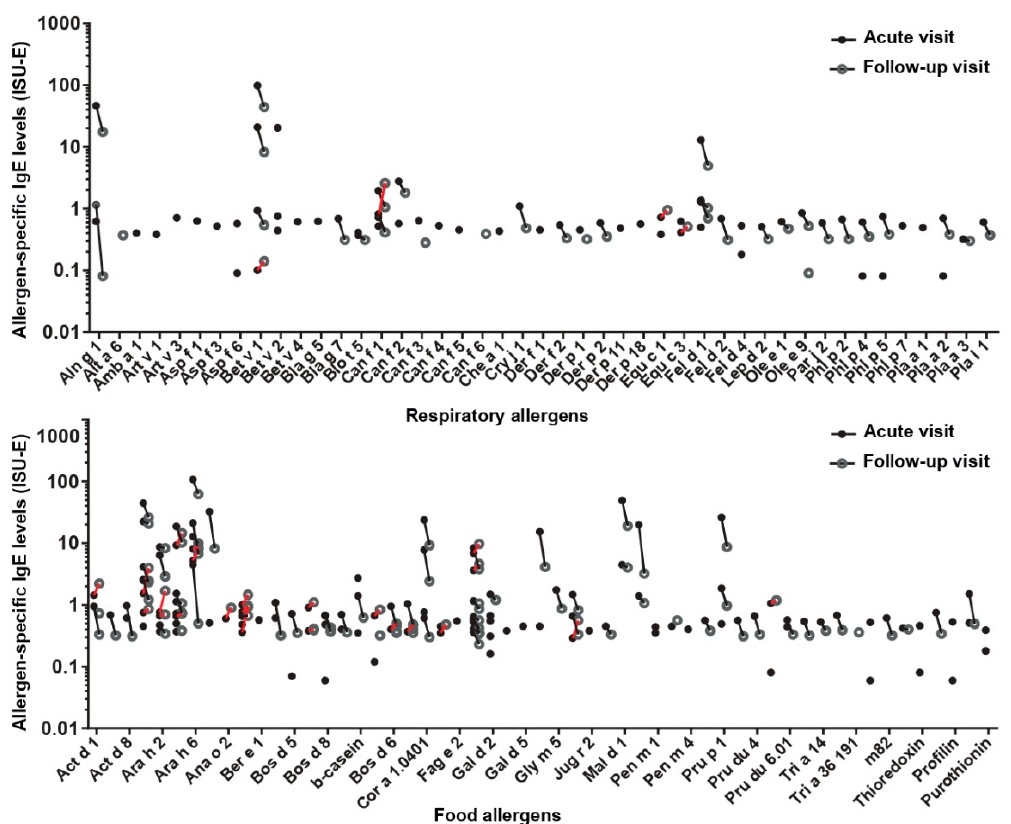
Figure 6. Alterations in allergen-specific IgE levels in sera during the acute and follow-up visits. Graphs show specific IgE levels (y-axes: ISU-IgE) for respiratory ( top ) and food allergens ( bottom ), determined during the acute and follow-up visits. Increases are indicated in red.